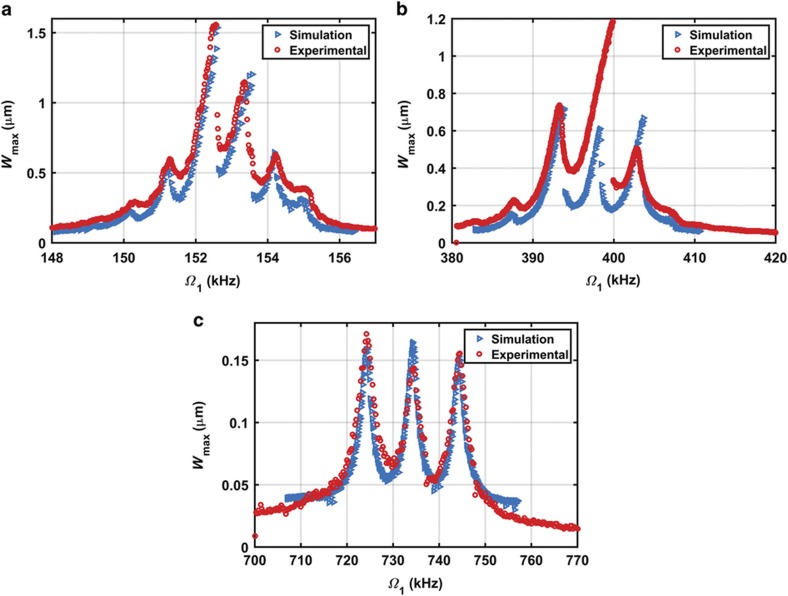
Experimental and simulation results of the microbeam. (a) Near the first mode of vibration for VDC=15 V, VAC1=5 V, VAC2=20 V, and Ω2=1 kHz; (b) Near the second mode of vibration for VDC=20 V, VAC1=15 V, VAC2=50 V, and Ω2=5 kHz; and (c) Near the third mode of vibration for VDC=20 V, VAC1=40 V, VAC2=40 V, and Ω2=10 kHz.